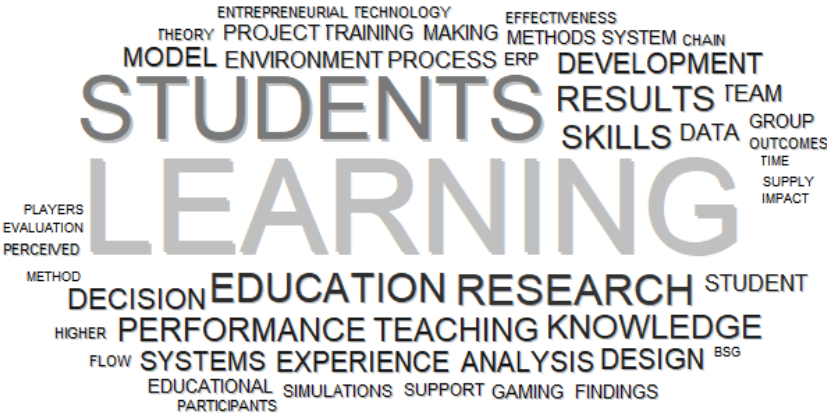
Figure 9. Word cloud word occurrence; Source: Authors’ work based on Scopus.